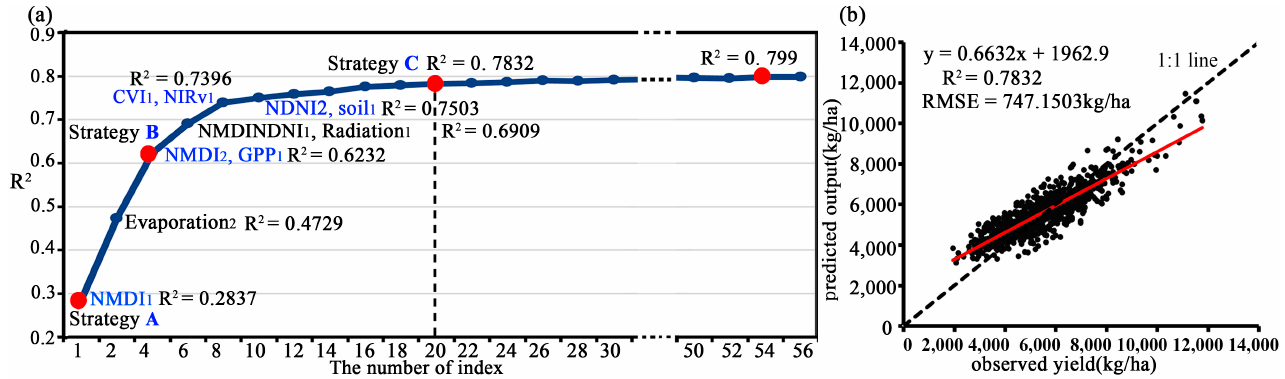
Figure 7. ( a ) Maize yield estimation by integrating multiple spectral indexes and temporal aggrega- tion data, ( b ) Maize yield estimation accuracy of strategy C. Note: NMDI 1 represents the value of the vegetative growth period. NMDI 2 represents the value of the reproductive growth period. Other items are similar.